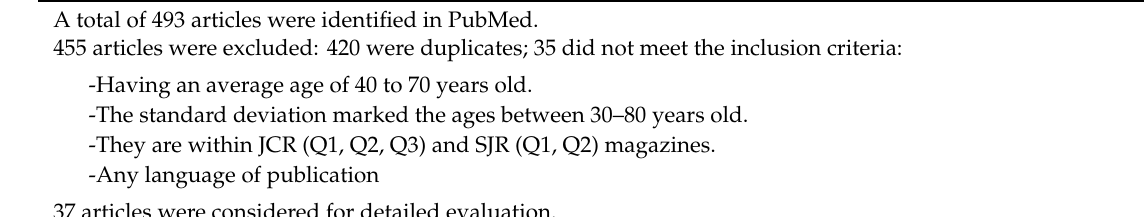
Table 1. Description of the item selection